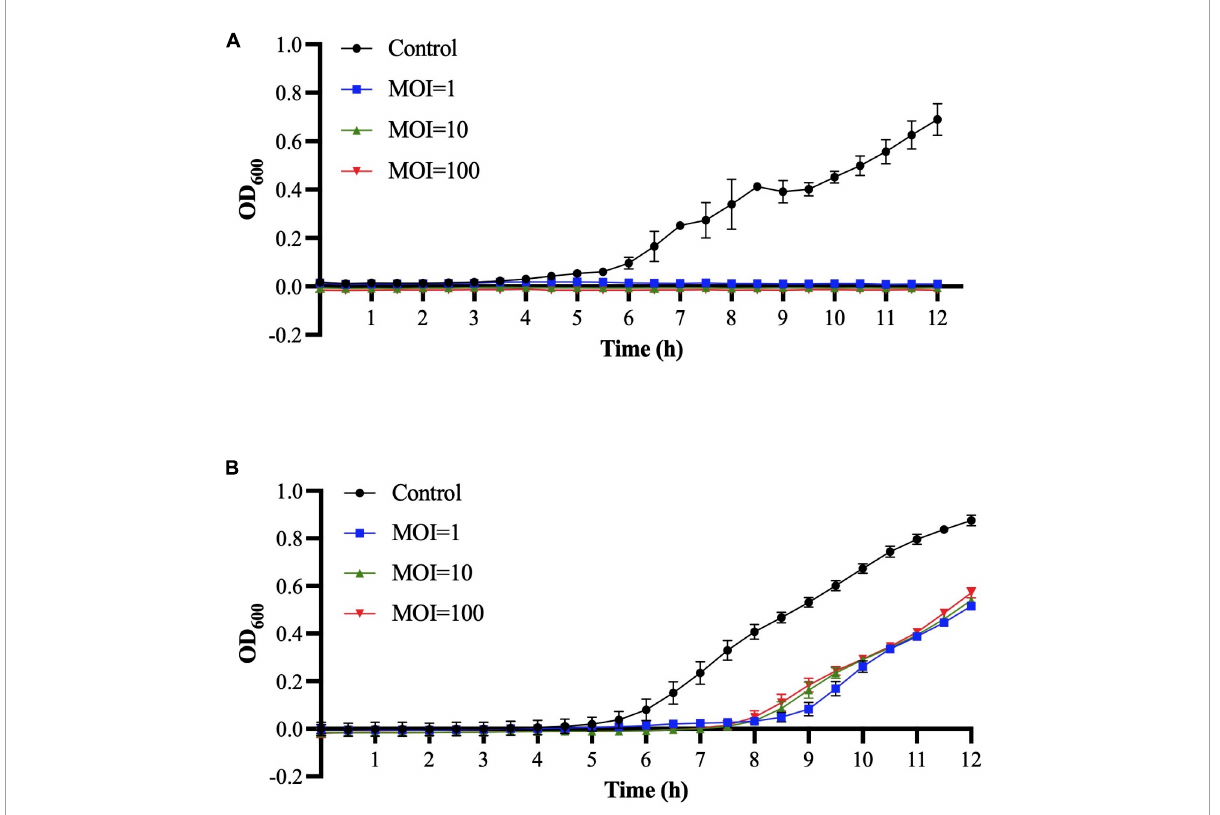
FIGURE6 Bacterial challenge assay for E. coli O157:H7 (A) and Salmonella Typhimurium (B) treated with phage Sa157lw at MOIs of 1, 10, and 100 at 25 ◦ C for 12 h based on the bacterial optical density at wavelength 600 nm (OD 600 ). The control group only contains bacterial culture.